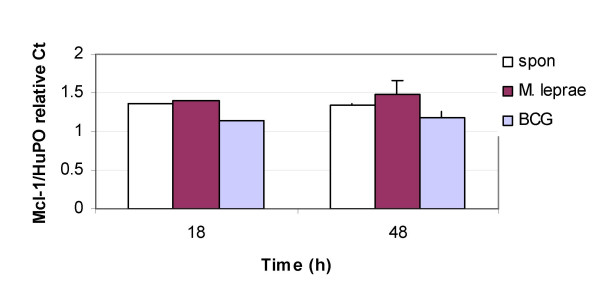
M. leprae upreglates Mcl-1 mRNA in THP-1 cells. THP-1 monocytes were infected with M. leprae or BCG at MOI-10 and RNA was harvested after 18 and 48 h of culture. mRNA was reverse transcribed and used for real-time PCR quantification of Mcl-1 and HuPO genes. Relative quantification data of 3 independent experiments calculated using the CT method is illustrated.